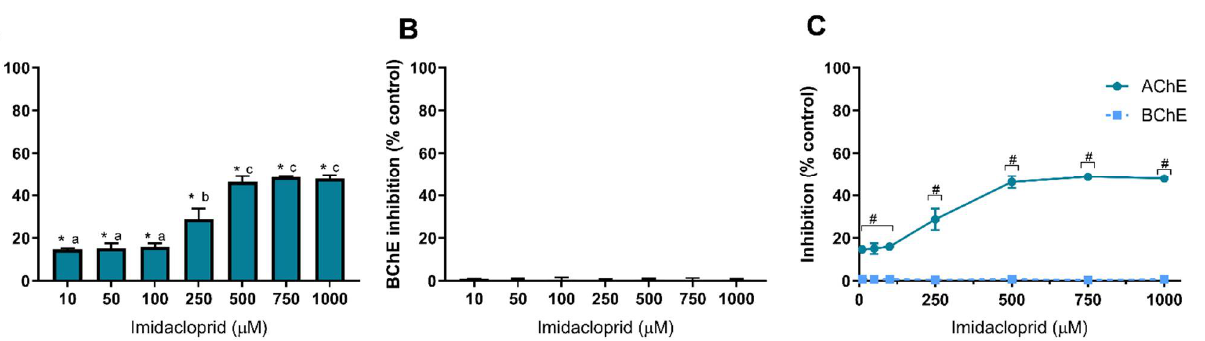
Figure 4. Imidacloprid-induced inhibition of AChE ( A ) and BChE ( B ), and comparison of cholinesterases affinity ( C ). Values are expressed as mean ± SD. Significant statistical differences between samples and the respective control are denoted by “*” ( A , B ) when p < 0.05, and differences between enzymes at the same concentration are denoted by “#” when p < 0.05 ( C ). Different letters were used to denote significant differences between concentrations when p < 0.05 ( A ). Statistical analysis details are described in methods (Section 2.3) and in Table